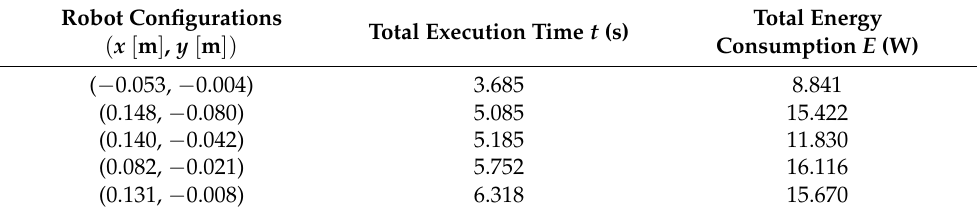
Table 2. Computational results with different robot configurations.